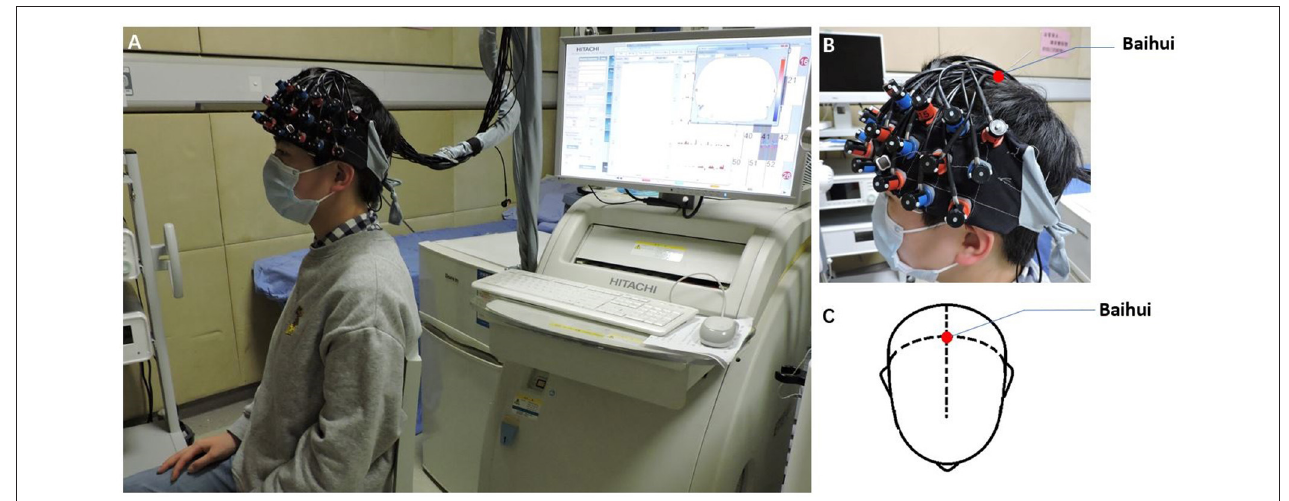
FIGURE 2 | Performing acupuncture. (A) Patients were asked to sit and relax on the seat in front of a near-infrared spectroscopy instrument. (B,C) The Baihui acupuncture point is shown.